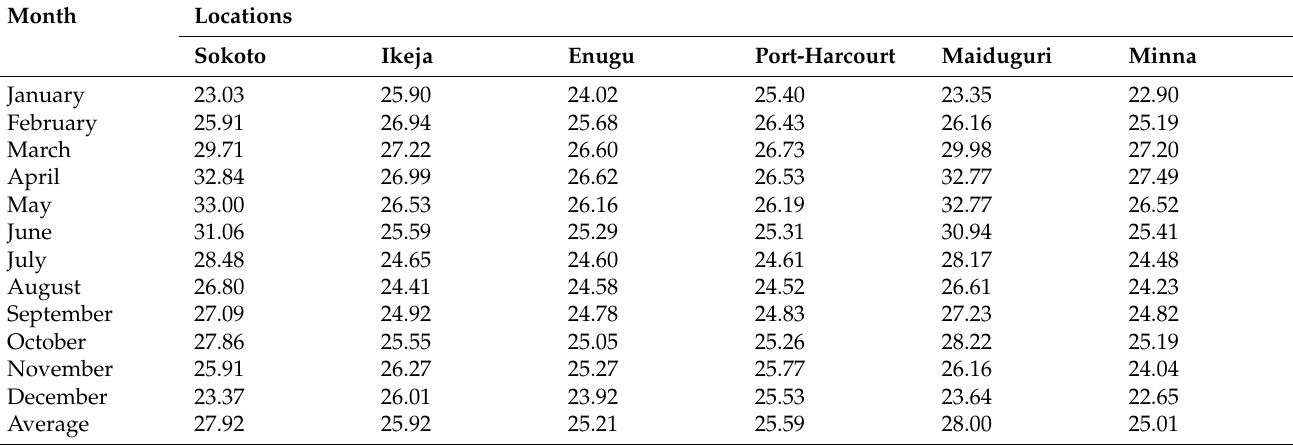
Table 7. Air temperature data of the case study sites for EVCS (degree celsius) [40].